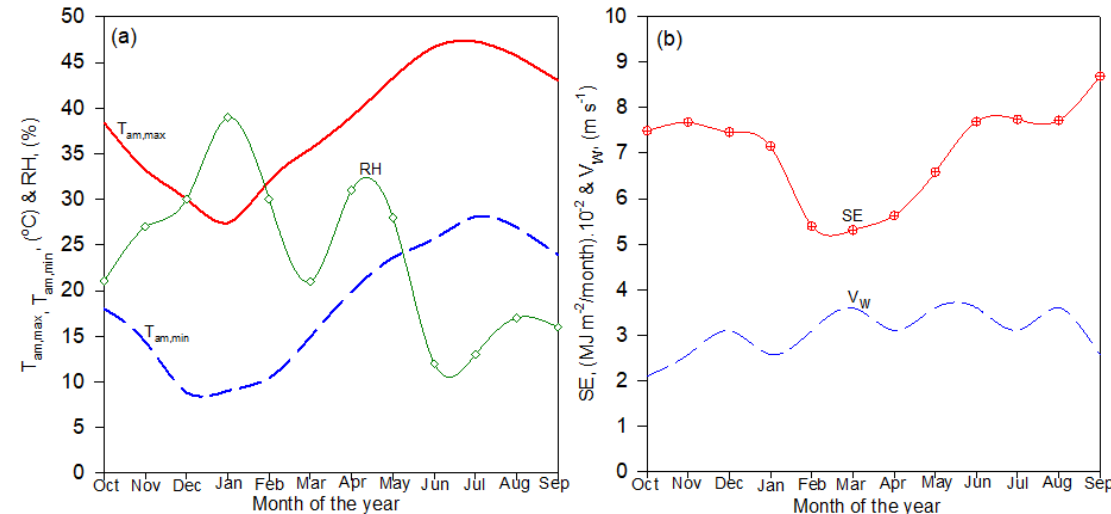
Figure 2. Variation of the meteorological parameters during the year of experiment (1 October, 2019–1 October, 2020). ( a ) Monthly average of the maximum and minimum ambient air tempera- ture and the relative humidity; ( b ) monthly average of the wind speed and monthly accumulated solar energy. On the x -axis of the upcoming figures (i.e., exposure time (month)), zero time repre-